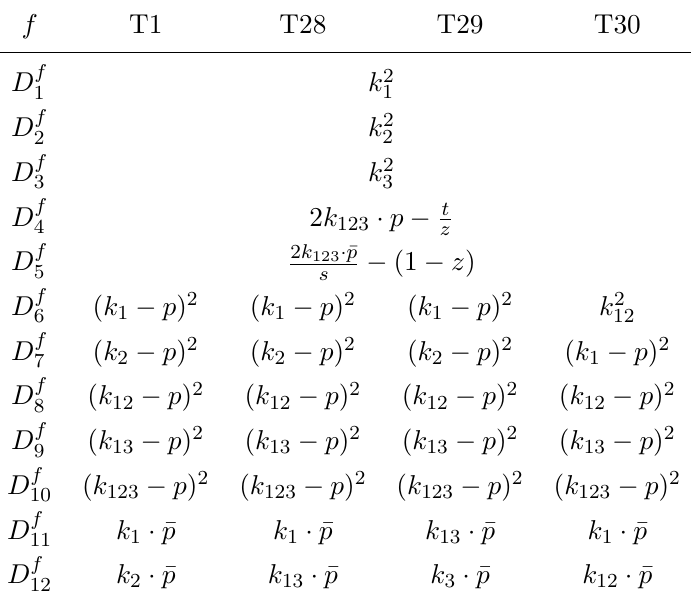
Table 2 . Integral family definitions for the example on partial fraction